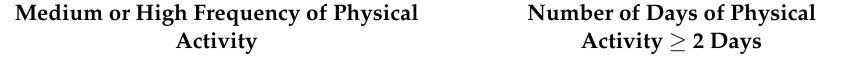
Table 2. Medium or high frequency of physical activity and number of days of physical activity ≥ 2 days among subjects with diabetes and gender–age-matched subjects without diabetes participants in the European Health Interview Surveys for Spain (EHISS) conducted in years 2014 and 2020 according to socio-demographic variables.